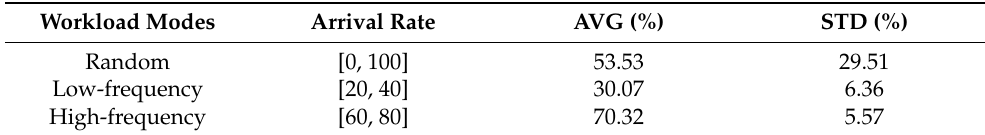
Table 4. Generation of load modes.